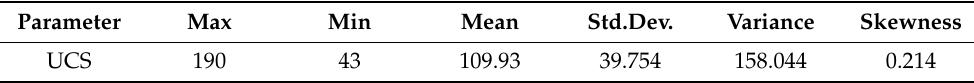
Figure 4. The normal distribution envelope of UCS results. Table 2. Statistical analysis for Maragheh limestone UCS results.